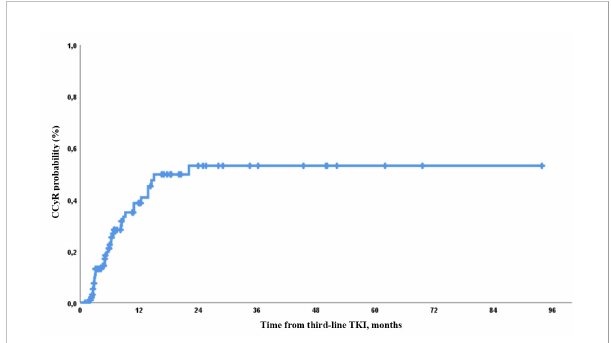
FIGURE 1 Probability of complete cytogenetic response (CCyR) achievement during third-line tyrosine kinase inhibitor (TKI)